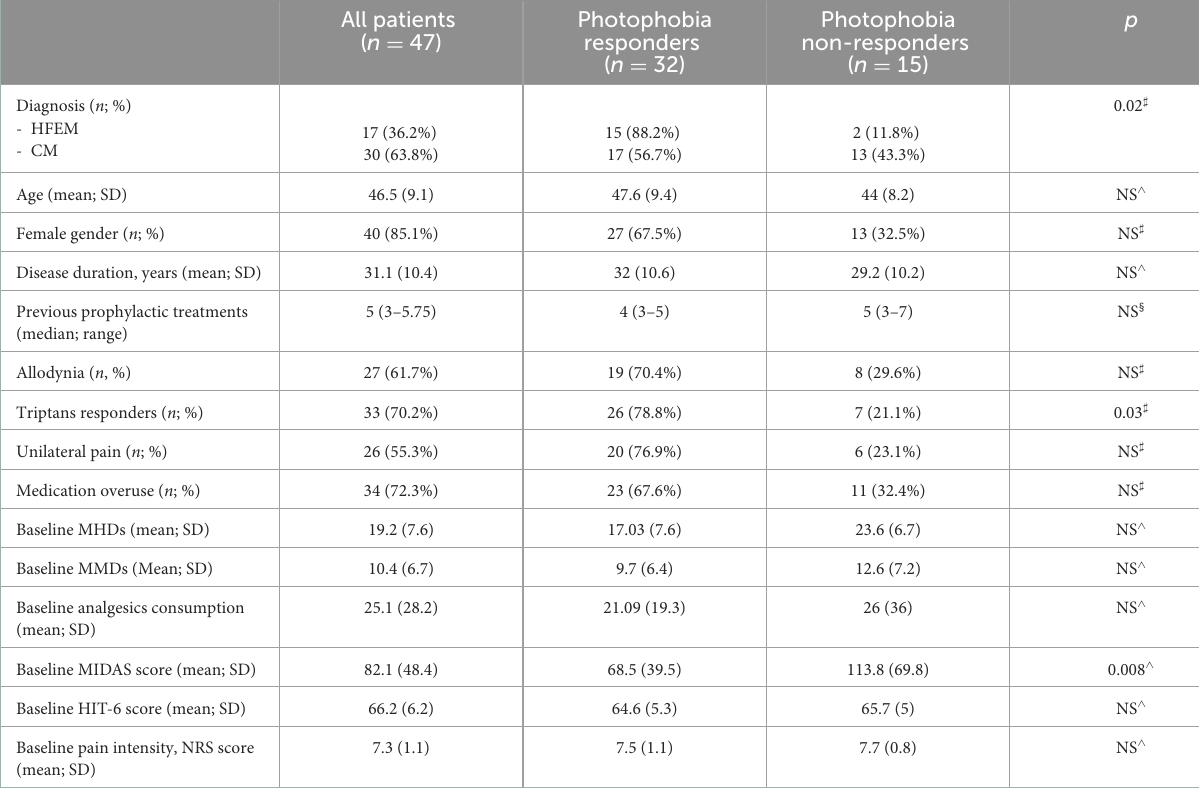
TABLE 1 Clinical and demographical characteristics of all patients.